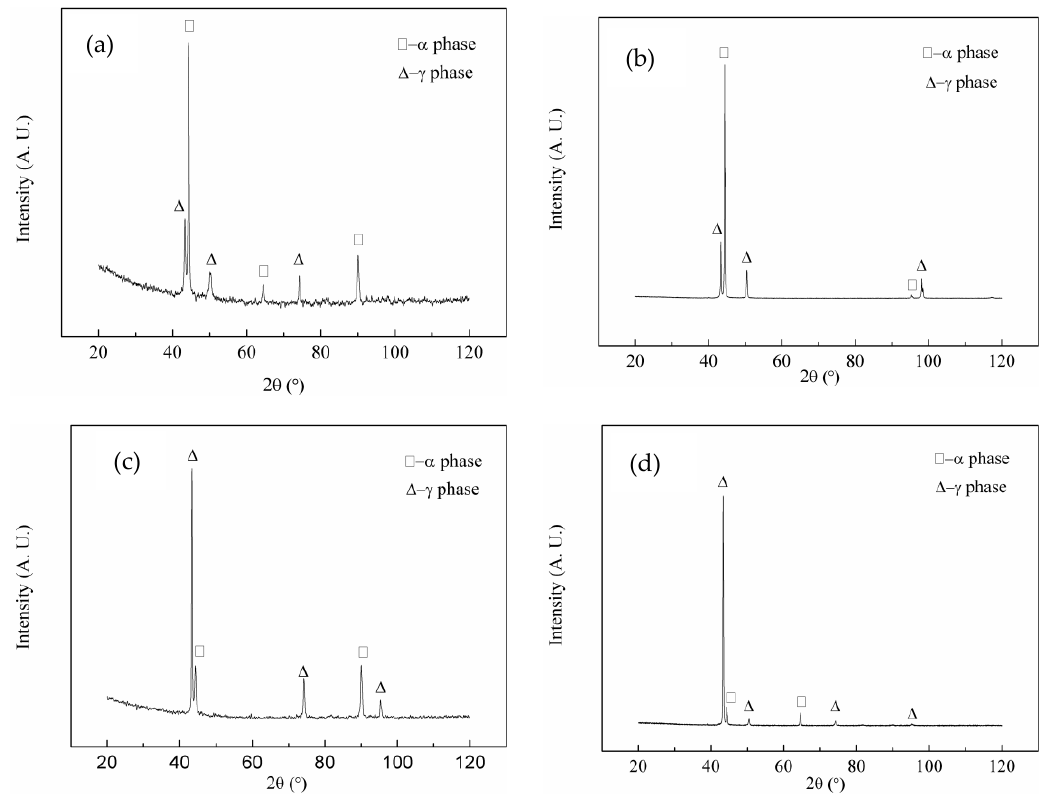
Figure 2. XRD patterns of NSSC 2120 after aging at di ff erent temperatures: ( a ) SX-650; ( b ) SX-750; ( c ) SX-850; ( d )